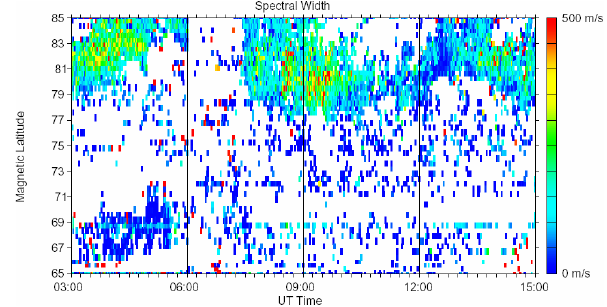
Figure 6. A magnetic local time–magnetic latitude snapshot of line- of-sight Doppler velocity and spectral width from the Hankasalmi SuperDARN radar from 03:00 to 15:00UT 9 December 2001.